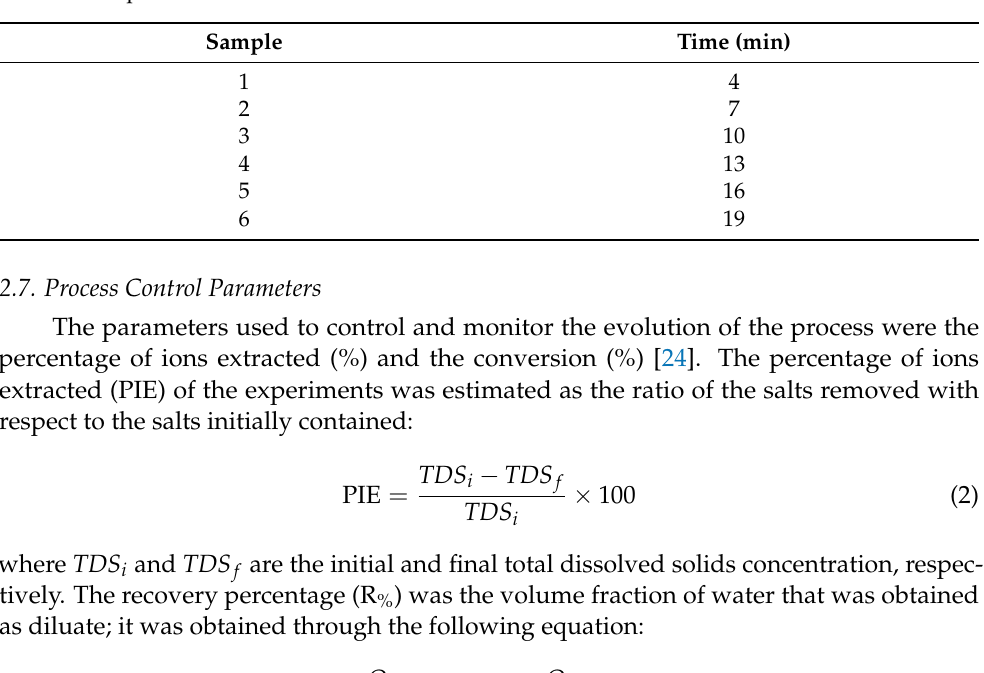
Table 2. Sample collection